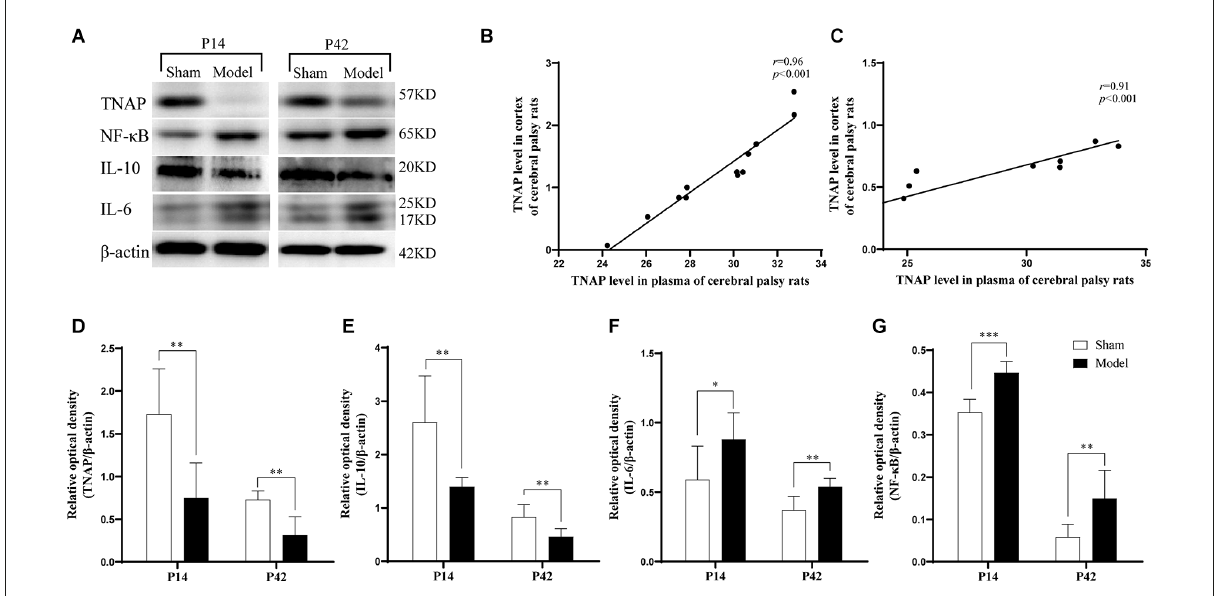
FIGURE6 (A) Representative Western blot images of TNAP, IL-10, IL-6, and NF- κ B in the injured cerebral cortex. (D–G) Compared with those in the Sham group, the cortex expression levels of TNAP and IL-10 were significantly reduced in the Model group ( p < 0.01, n = 6). Compared with those in the Sham group, the levels of IL-6 ( p < 0.05, p < 0.01, n = 6) and NF- κ B ( p < 0.001, p < 0.05, n = 6) were significantly increased in the Model group. (B,C) On day 7 ( p < 0.001, r = 0.96, n = 12) and day 35 post-HIE-modeling ( p < 0.001, r = 0.91, n = 12), there was a positive correlation in the levels of TNAP between the peripheral plasma and the brain. *Denotes statistical significance. ∗ p < 0.05 vs. Sham. ∗∗ p < 0.01 vs. Sham; ∗∗∗ p < 0.001 vs. Sham.